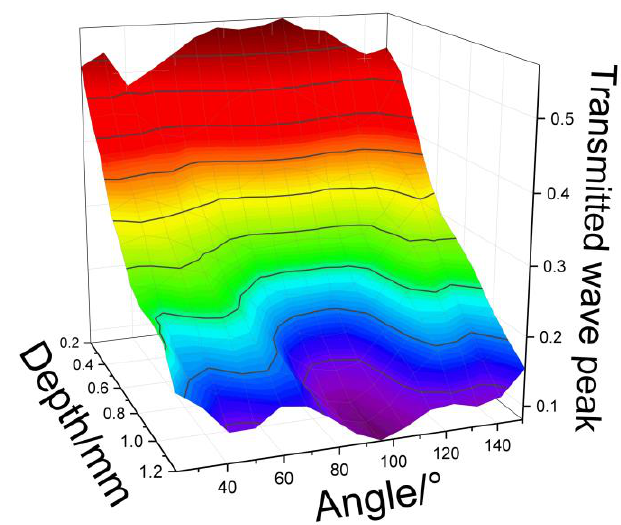
Figure 7. Three-dimensional map of the angle – depth – transmitted wave